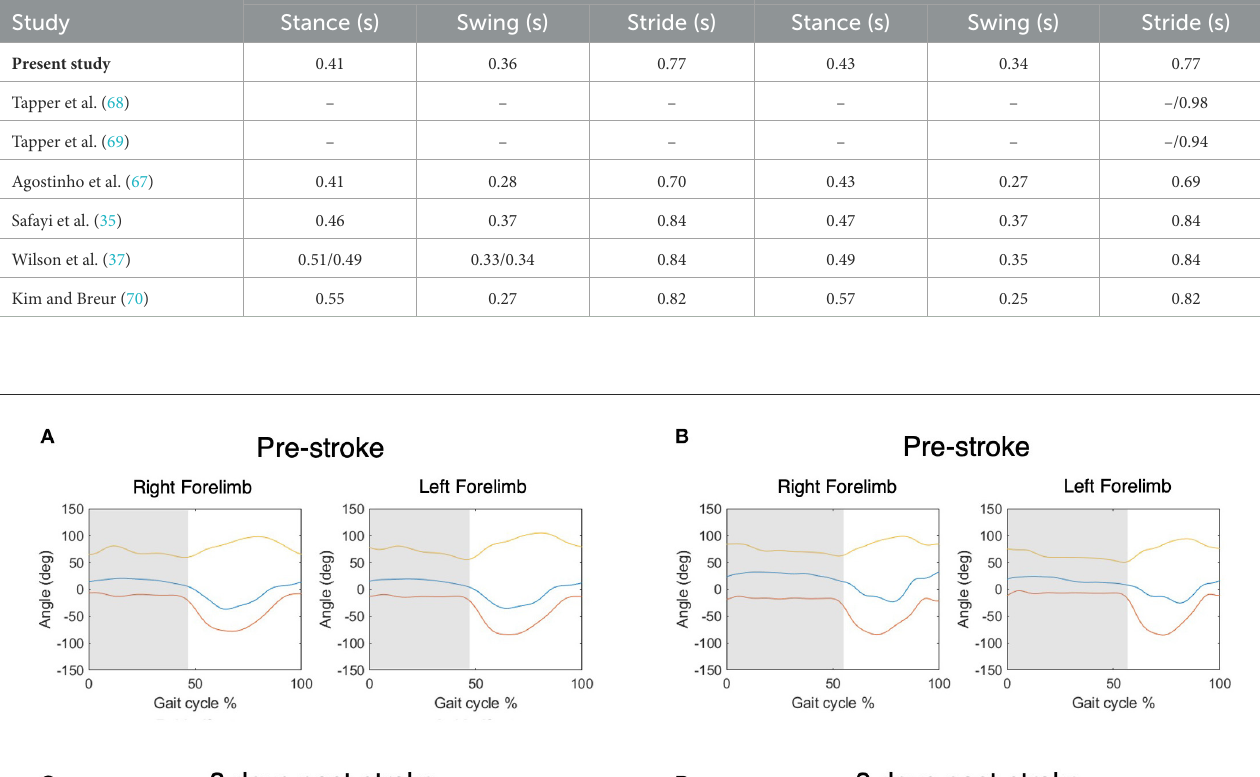
TABLE 4 Average stride, swing and stance duration in clinically healthy sheep. Forelimb (L/R where applicable)